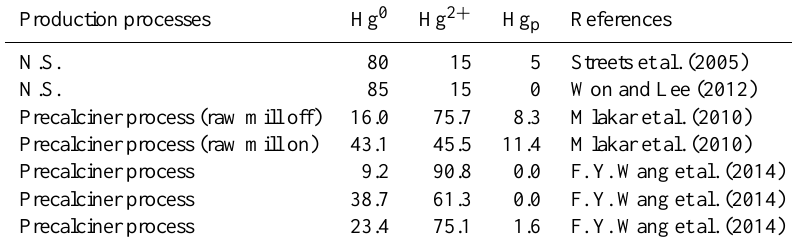
Table 3. Average proportions of emitted mercury species from cement clinker production (%). Production